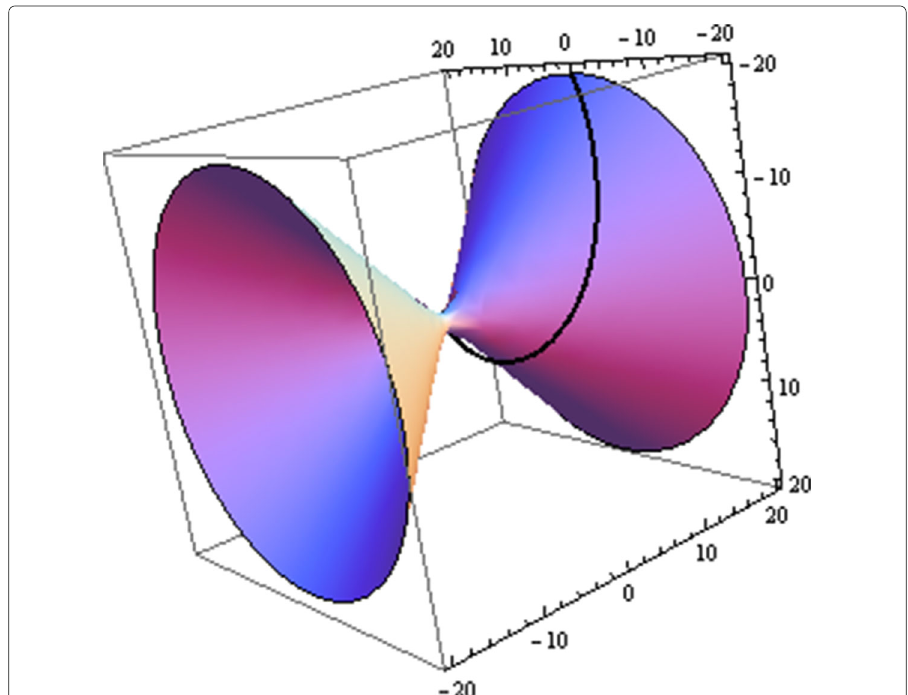
Fig. 6 The spacelike equiform-Bishop TB 1 B 2 -Smarandache curve ϕ(σ ∗ ) on S 2